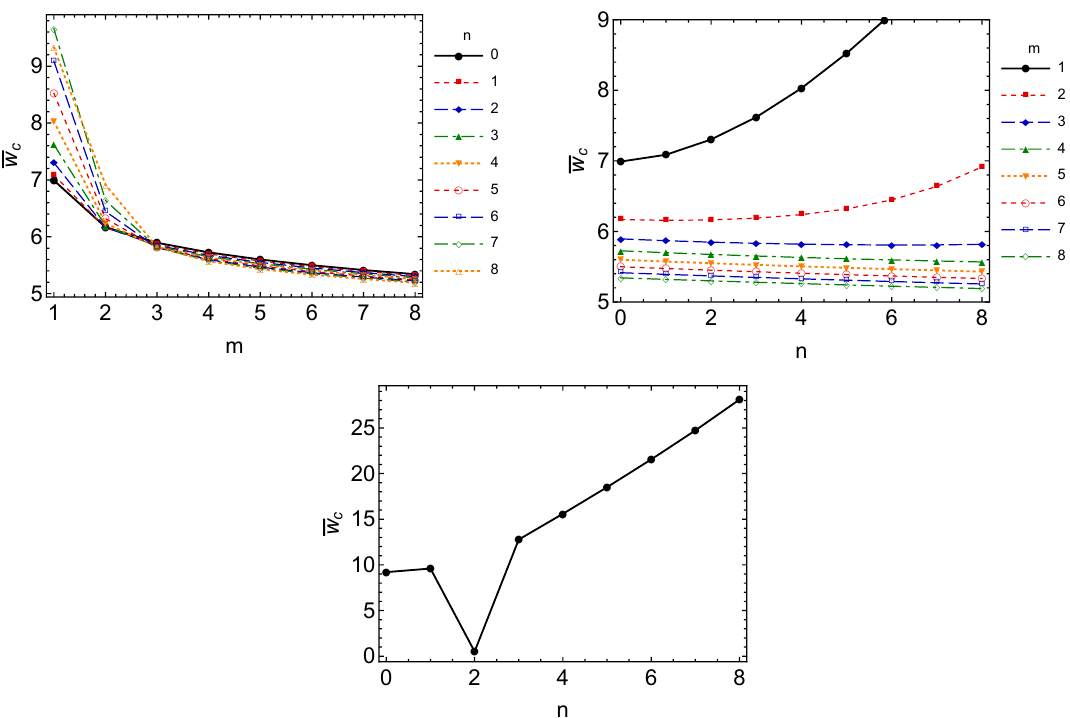
Figure 8 . The pseudo-thermalization time w c for n; m 2 f 1 ; (cid:1) (cid:1) (cid:1) ; 8 g . The top left panel shows w c as a function of m with the lines corresponding to di(cid:11)erent values of n . The top right panel shows w c as a function of n with the lines corresponding to di(cid:11)erent values of m . The bottom panel shows w c as a function of n for the case m =